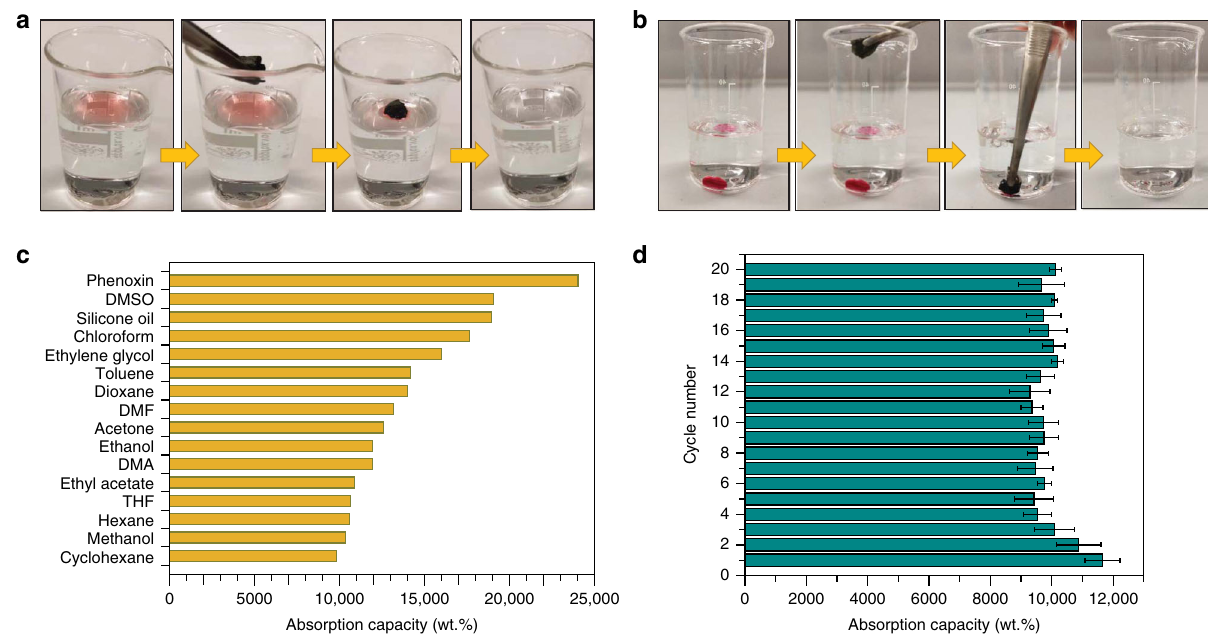
Fig. 3 Absorption performance of COF/rGO aerogels. Absorption of dyed silicone oil ( a ), and chloroform ( b ), from water by COF/rGO aerogels. c Absorption ef fi ciency, and d cycling stability of COF/rGO in terms of weight gain. The error bars exhibit standard deviations based on three independent measurements. Dimethyl sulfoxide, dimethylformamide, dimethylacetamide, and tetrahydrofuran are abbreviated as DMSO, DMF, DMA, and THF, respectively.